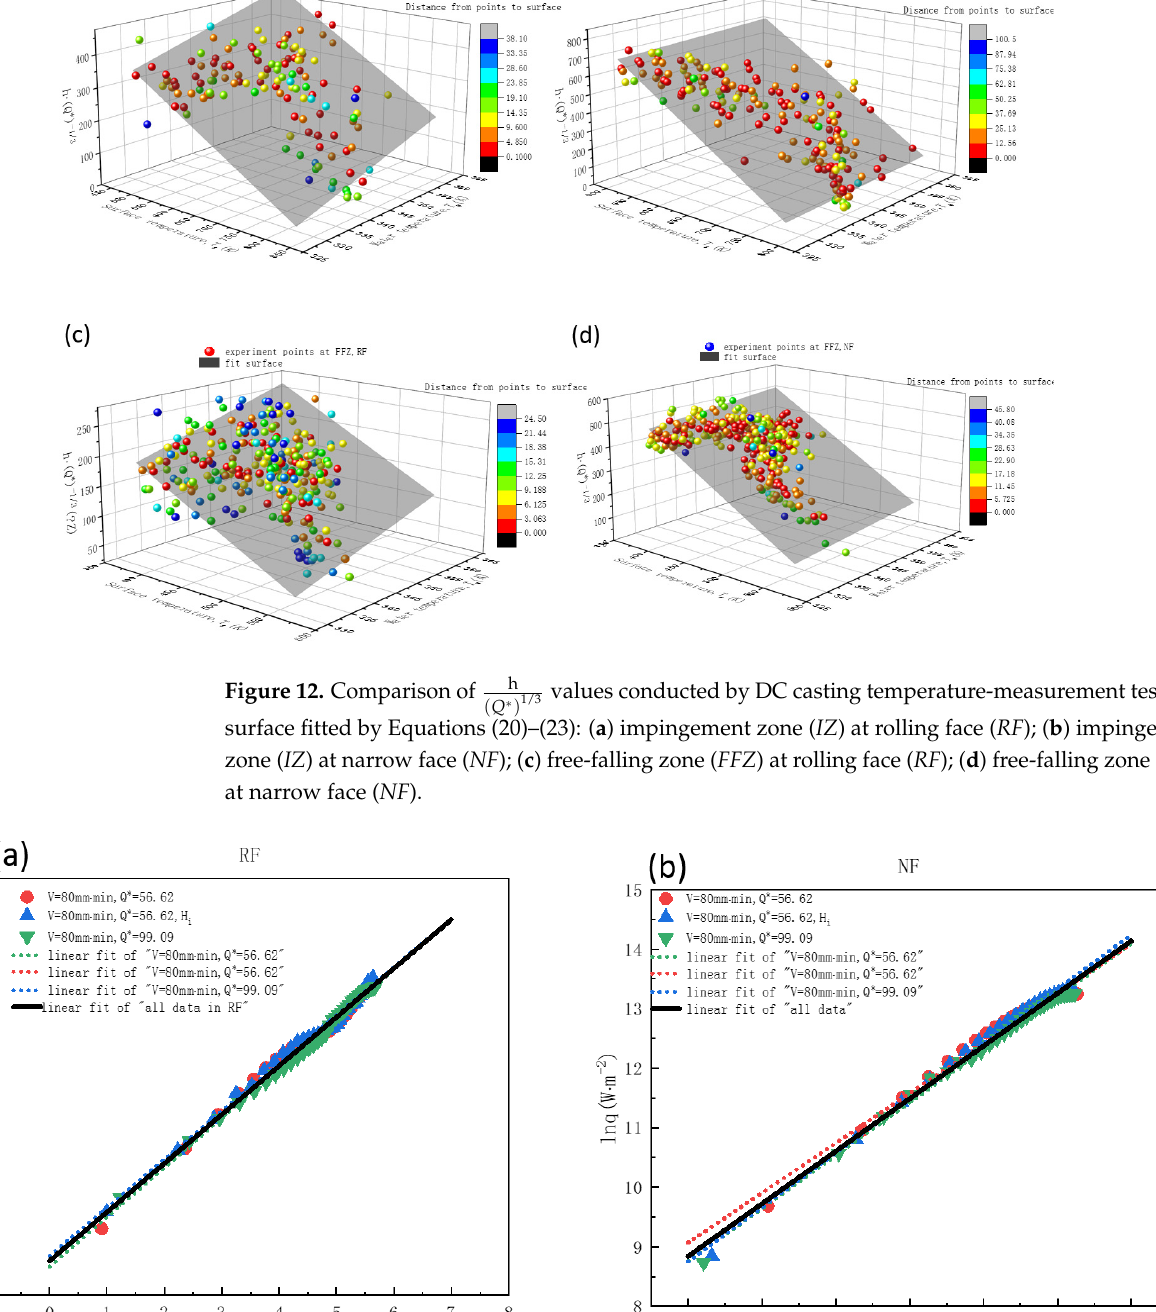
Figure 13. Correlation between data calculated by Equations (22) and (23) and the data gained by DC casting temperature-measurement test: ( a ) at RF ; ( b ) at NF .